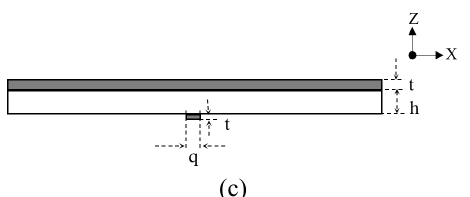
Figure 1: Configuration of the proposed slot antenna loaded with a pair of rotated square split ring resonators (a=60mm, b=42mm, c=50mm, d=25mm, e=14mm, f=12mm, g=1mm, h=1.6mm, i=9mm, j=11 mm, k=13mm, l=9mm p=13.5mm, q=1.5mm, t=0.03mm) (a) Front view (b) Back view (c) Side